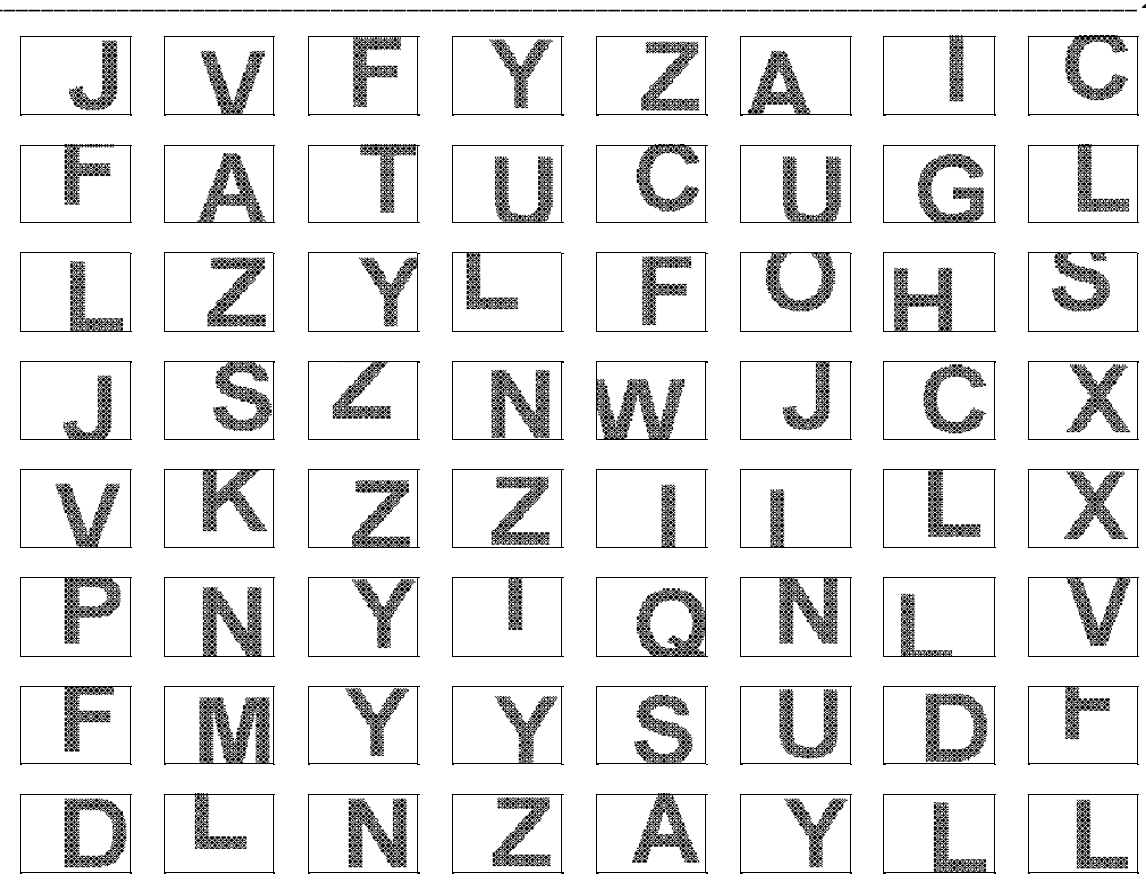
Fig. 7. SDM6080I by SSD 1   , recognised with SDM6080IPD-trained classifier 4800-240-26-PO by PSSDR * 0.05 r  at CEP (34). SDM6080I